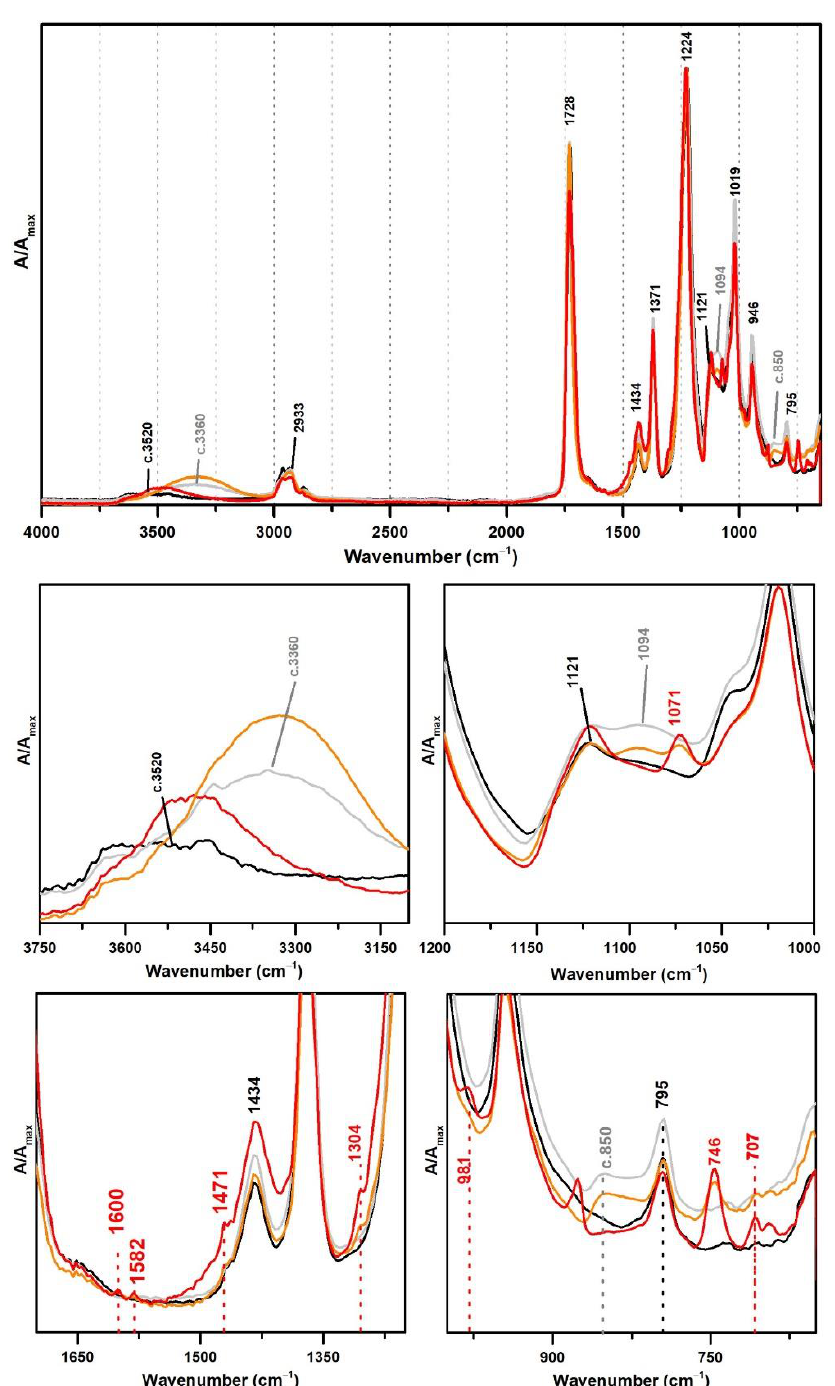
Figure 9. Infrared spectra in ATR of the pure PVAc emulsion (black), PVAc stabilised with PVAl (10%) (grey), Giotto Vinilik White PVA Glue (orange) and V2 Cola Tudo Incolor (red).